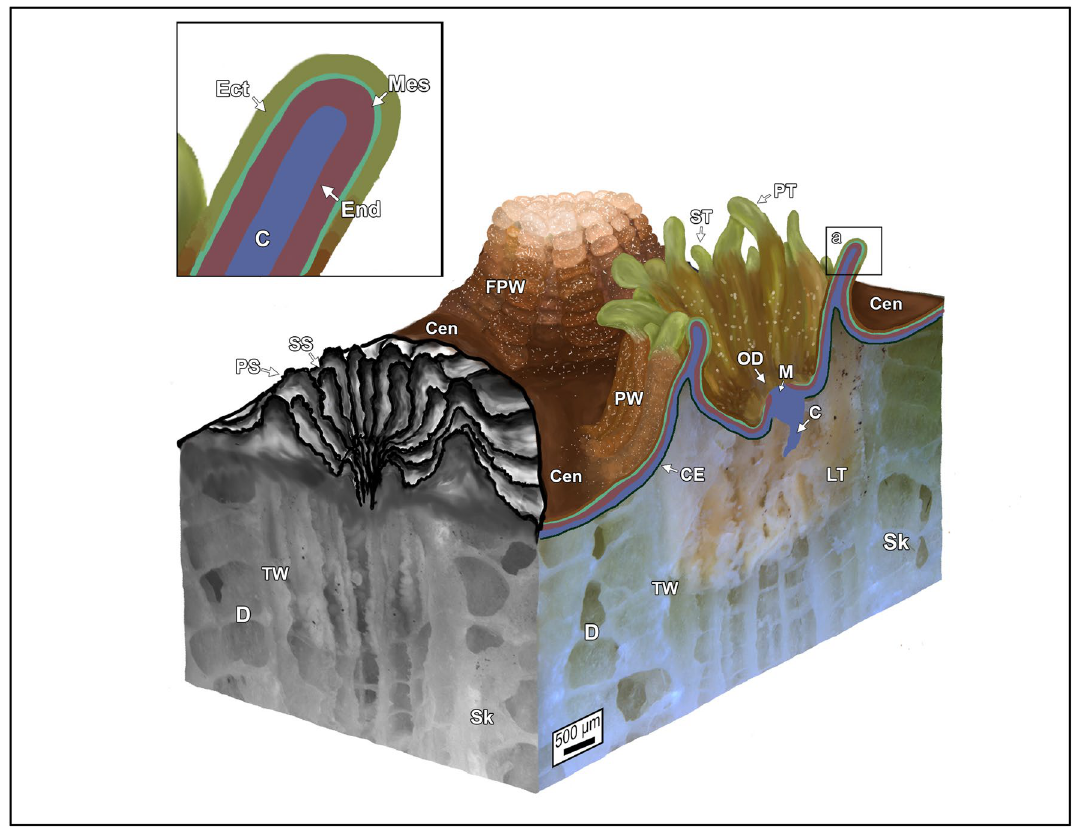
Figure 3. Three-dimensional (3D) block diagram and tissue schematic for Orbicella annularis and O. faveolata. The sketched uppermost surface of the block diagram shows an extended polyp (right), a retracted polyp (center) and skeletal cup (corallite; left). The vertical side walls of the block are actual photographs of a tissue- skeleton biopsy collected form O. annularis. Labels include: Cen–ceonosarc; FPW–folded polyp wall; PT– primary tentacle; ST–secondary tentacle; OD–oral disk; M–mouth; C–coelenteron; CE–calicoblastic epithelium; Sk–skeleton; D–dissepiment; LT–living tissue within the skeleton; TW–thecal wall; PS–primary septum; SS– secondary septum. Schematic enlargement ( a ) illustrates the following basic tissue: C–coelenteron; End–oral endoderm; Mes–mesoglea; and Ect–oral ectoderm. Tissue and skeletal structure terminology after Allemand et al. 54 and Peters 55